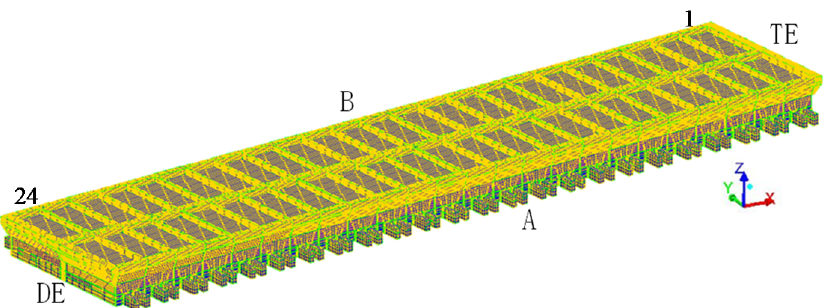
Figure 1. Physical model of bath–metal two-phase flow in 500 kA cell. TE: Tapping End; DE: Duct End, Side A: Upstream of cell; Side B: Downstream of cell.